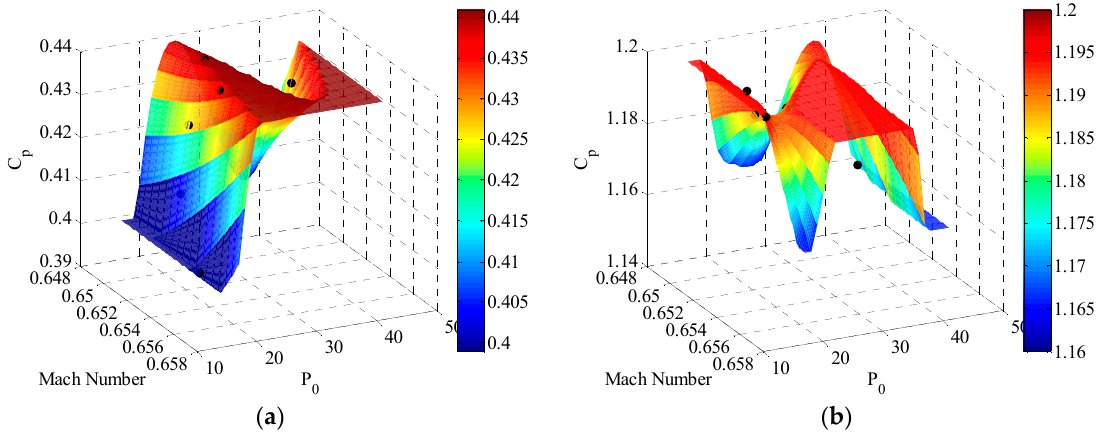
Figure 7. Data interpolation using the response surface model reconstructed based on flight Mach number and total pressure (original experimental data are superimposed for comparison): ( a ) probe No. = 5; ( b ) probe No. = 45.